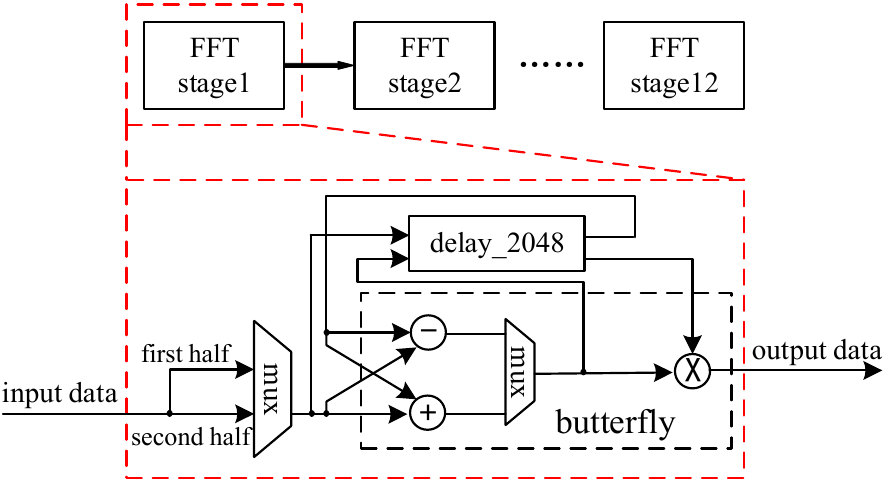
Figure 8. Pipeline structure of